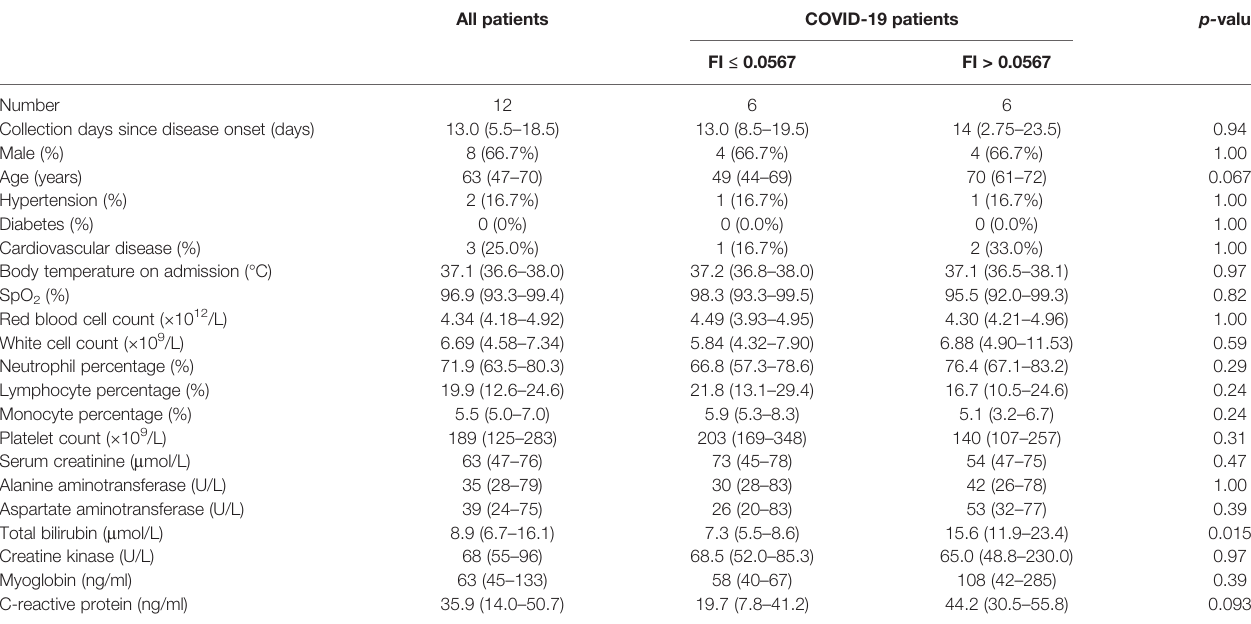
TABLE 1 | General characteristics of COVID-119 patients classi fi ed by pulmonary fi brosis index. All patients COVID-19 patients p-